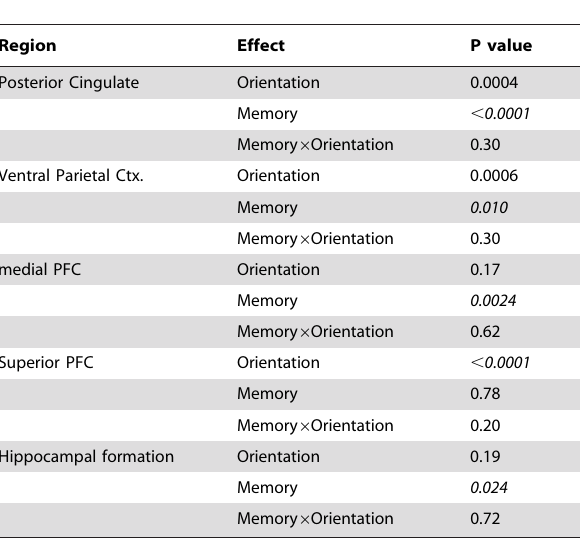
Table 3. Main effects and interactions during episodic encoding.